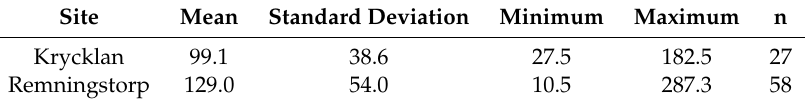
Table 2. Summary of aboveground biomass values (in t ha − 1 ) of the forest